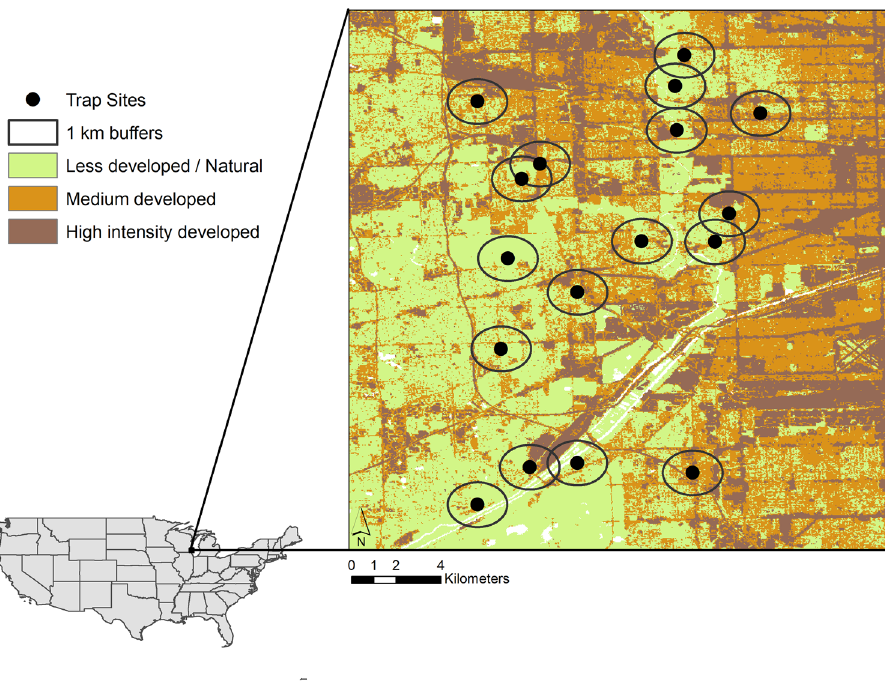
Figure 5. Distribution of mosquito surveillance trap sites across less developed and medium developed landscapes in suburban Chicago. Map was created using ESRI ArcMap v10.6 software program (https:// www. esri.